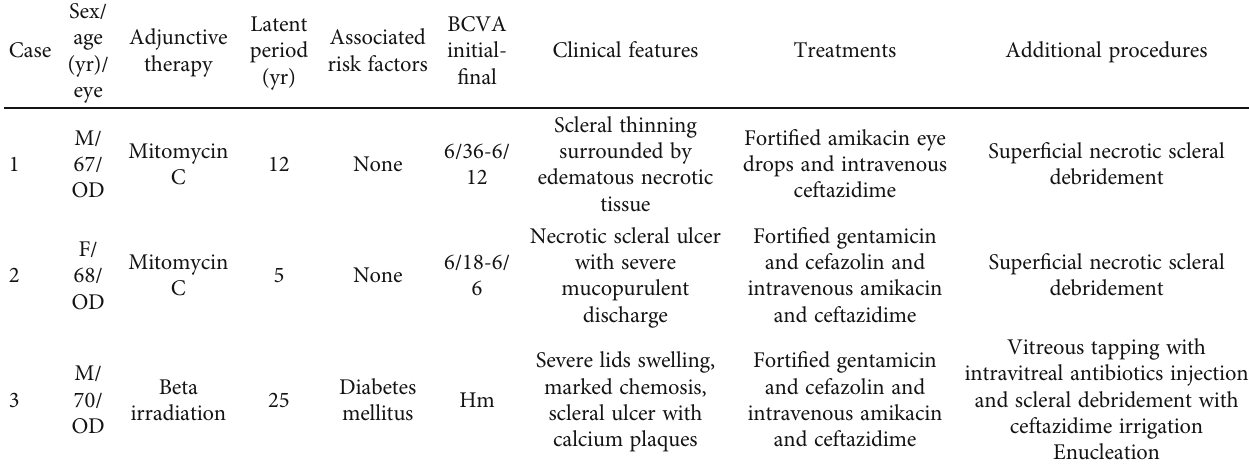
Table 1: Demographics, clinical characteristics, treatments, and outcomes of three cases with Pseudomonas aeruginosa scleritis. Case